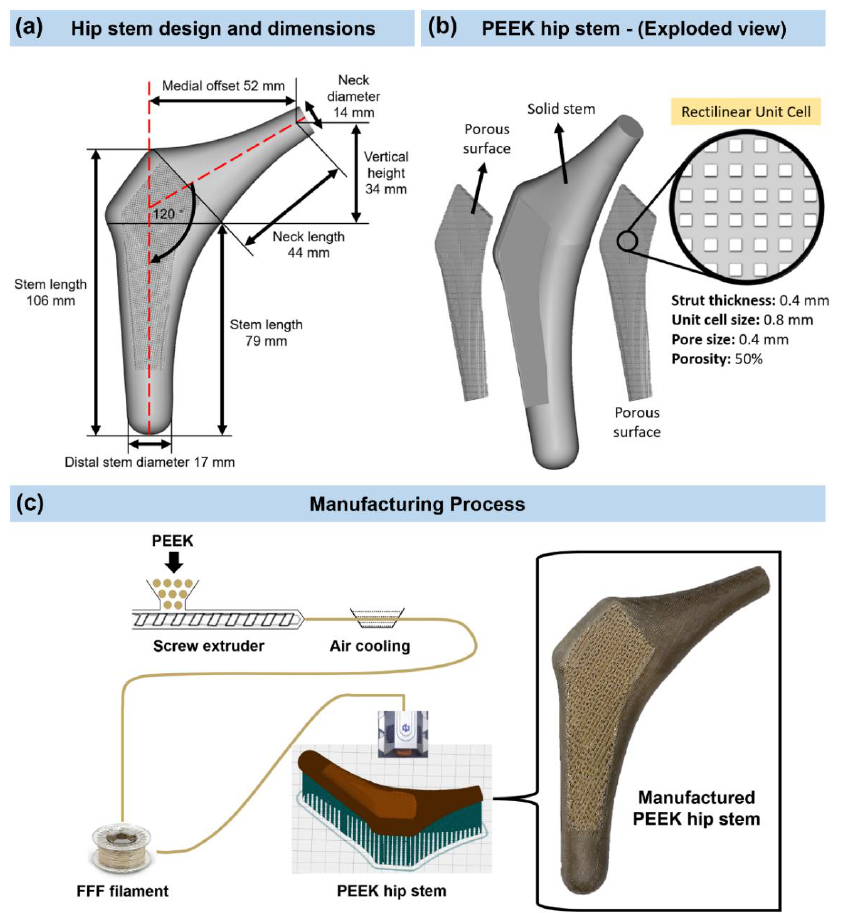
Figure 2. (a) Design and dimensions of the hip stem. (b) Isometric exploded view of the PEEK hip stem. (c) Manufacturing process and 3D printed PEEK hip stem with porous surface rectilinear scaffolds unit cells. Table 2. The process parameters of 3D printing.